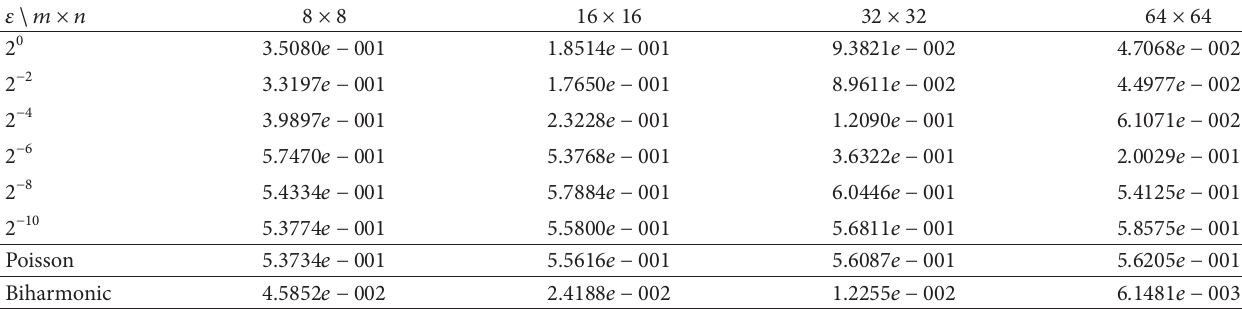
Table 1: The errors |‖𝑢 − 𝑢 ℎ ‖| 𝜀,ℎ /|‖𝑢‖| 𝜀,ℎ employing approximation form (12) under mesh